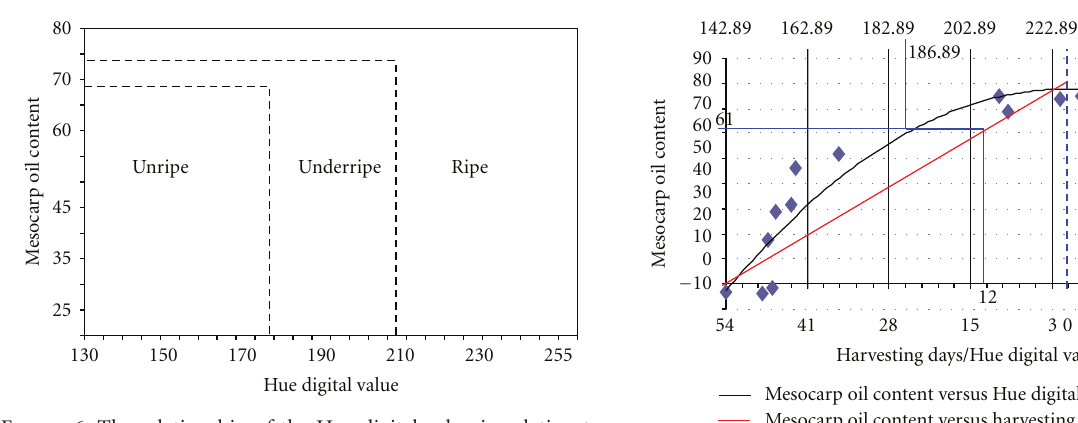
Figure 6: The relationship of the Hue digital value in relation to maturity level of oil palm FFB.